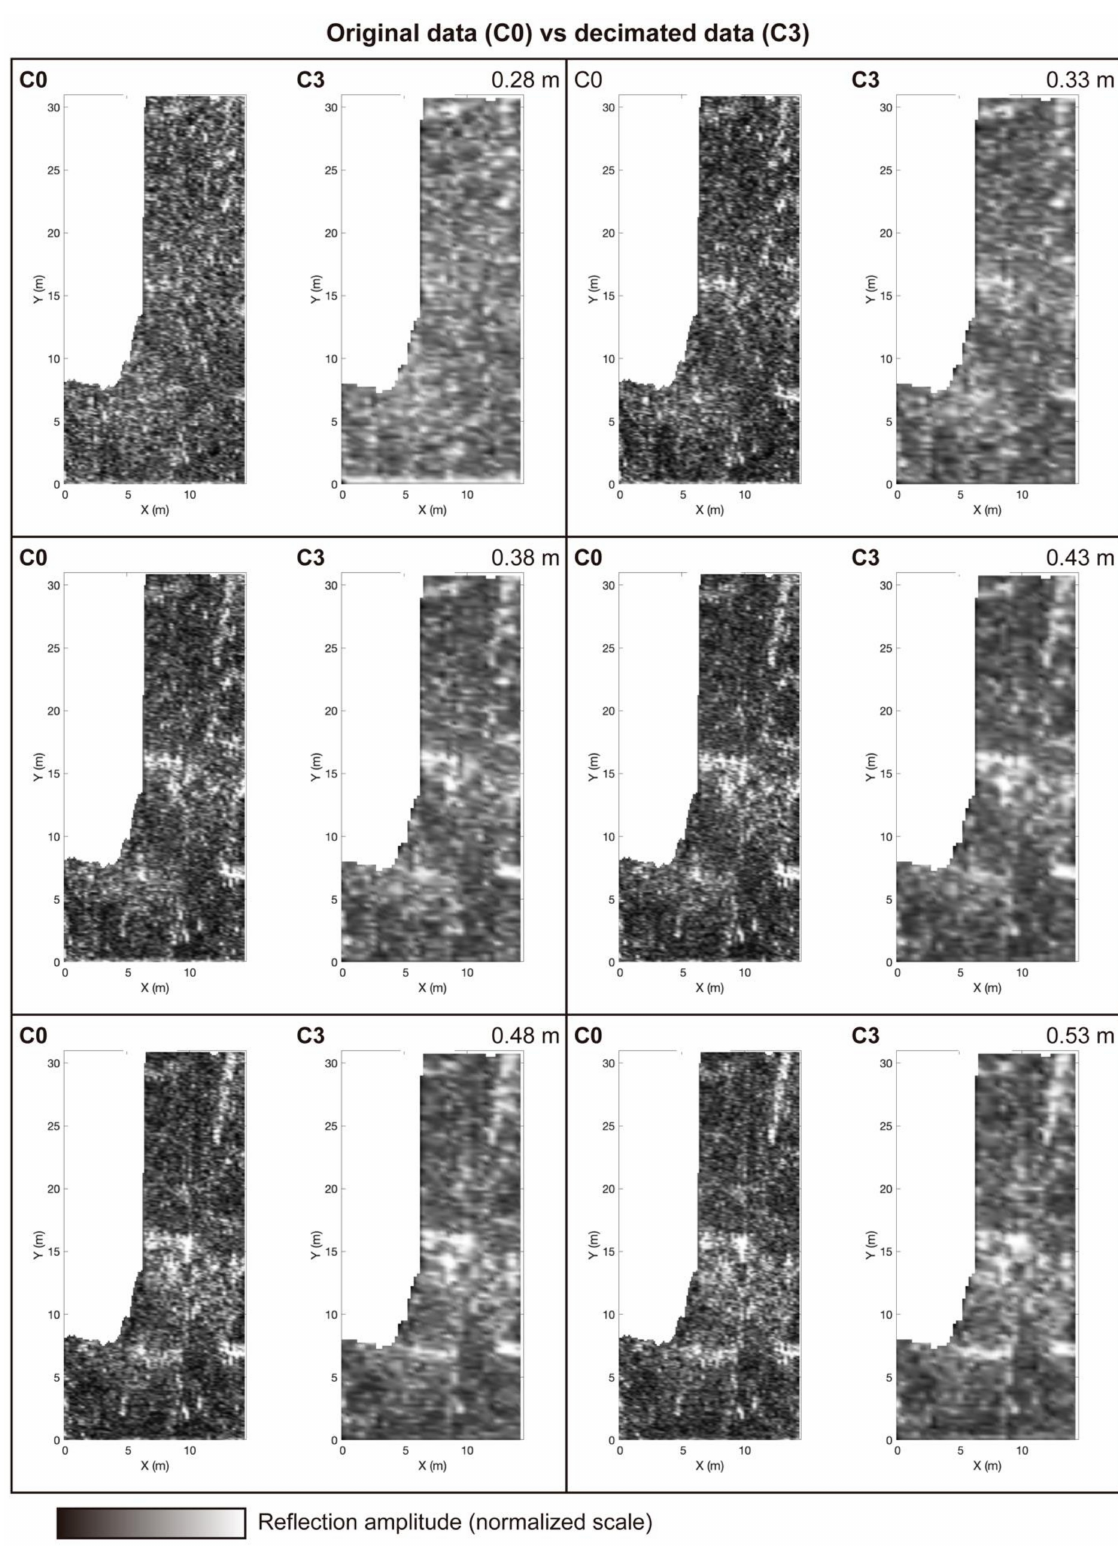
Figure 9. Differences between the original data (C0—d = 0.250 m) and the decimated data (C3—d = 0.500 m). The decimated data allow us to observe that the increase in the distance be- tween B-scans during the acquisition step impairs the